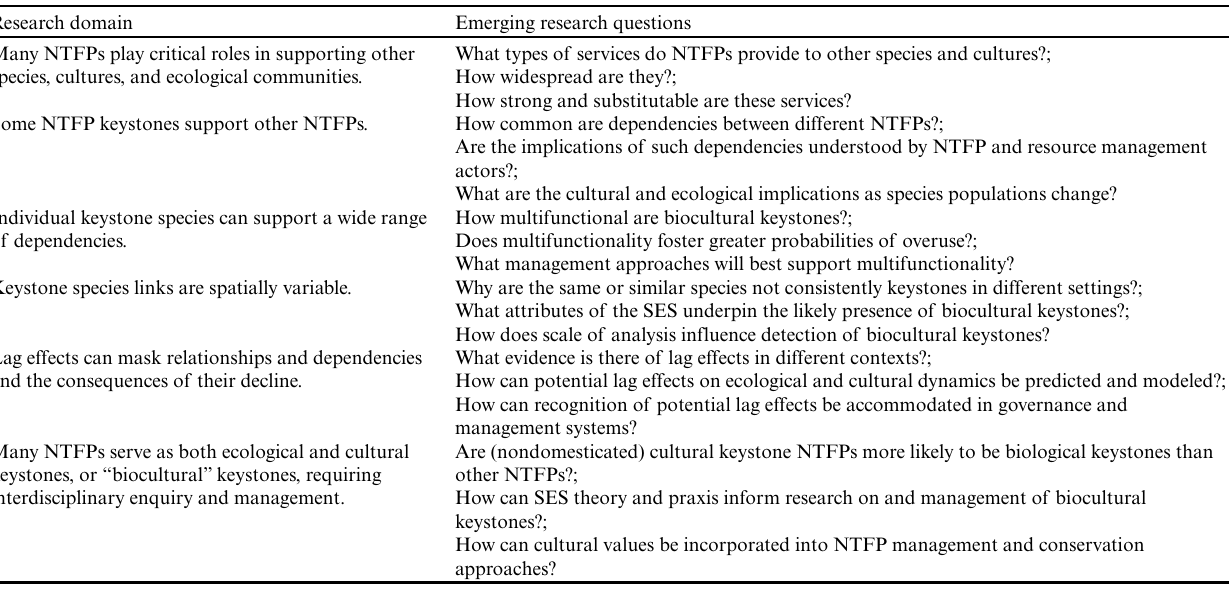
Table 2 . Emerging research questions around nontimber forest products (NTFPs) as biocultural